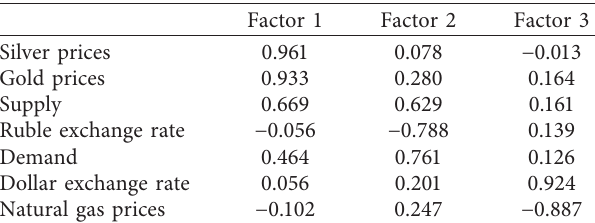
Table 2: Component matrix.